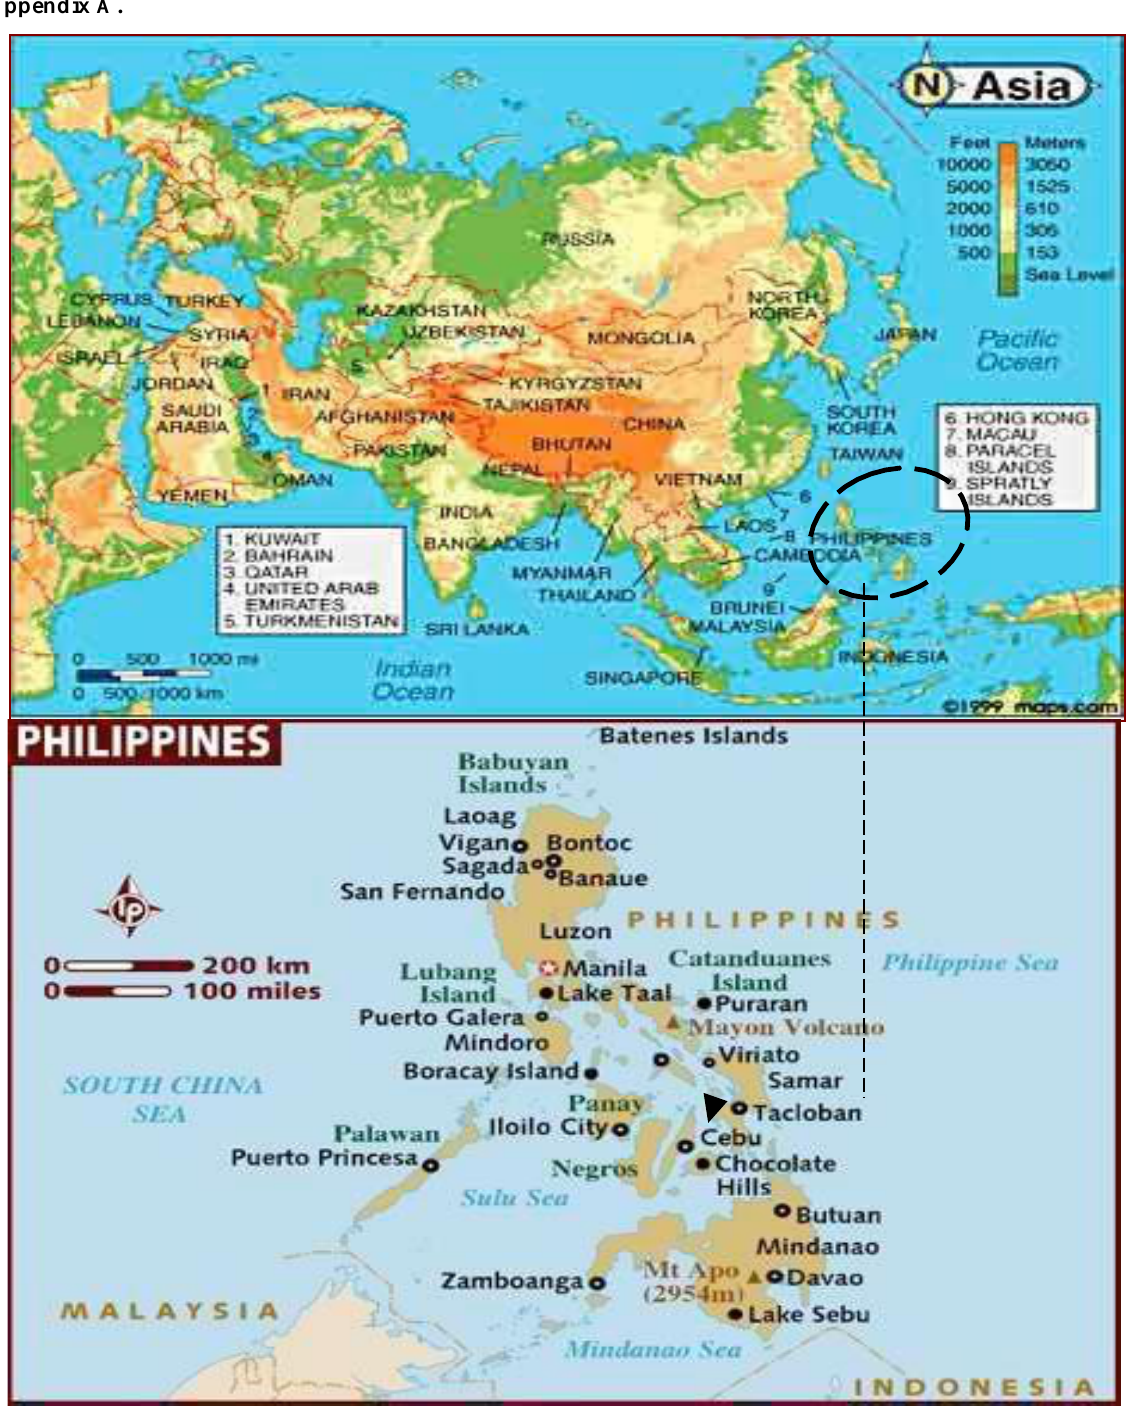
Figure 1. Map Showing the Locale of Cebu City,